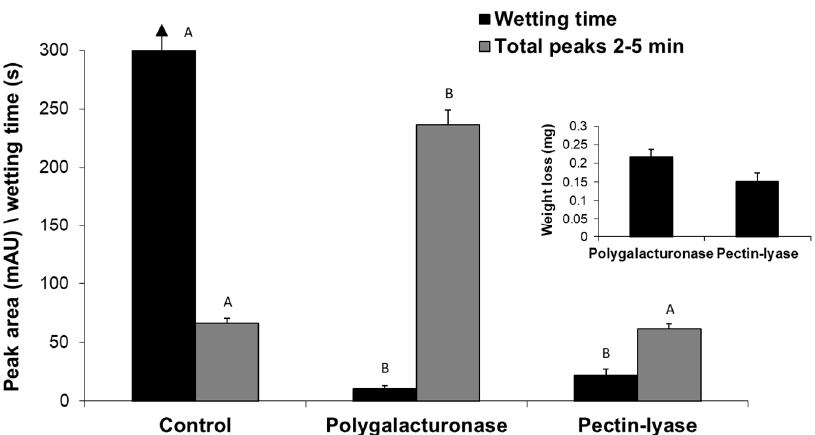
Figure 6. Effect of polygalacturonase and pectin lyase on cotton fabrics wetting time, weight loss (insert), and the appearance of pectin decomposition products in the reaction fluid. Raw cotton fabrics (850 mg per reaction) were incubated for 20 h in a rotary shaker (175 rpm) at 37 °C with 182.6 U/mL polygalacturonase or 341.0 U/mL pectin lyase in the absence of detergent. Each enzyme was incubated under its optimal conditions: 50 mM acetate buffer, pH 5, and 100 mM phosphate buffer, pH 8, respectively. Pectin hydrolysis products were detected using ELSD-RP HPLC, as illustrated in Figure 5. Values represent an average of three independent replicates, except for the weight loss values that are an average of two replicates. Arrows represent wettability values above 500 s (the experiment discontinuance). Bars indicate standard error. Levels not connected by the same letter (A, B) differ significantly from the other treatments in the same measure ( p < 0.05, ANOVA).